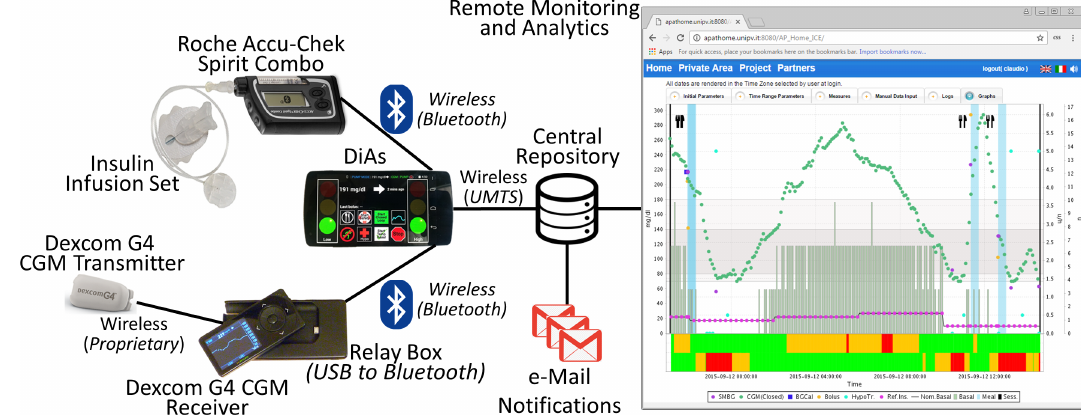
Figure 4. The architecture illustrating the components used in the final trial of AP@home , with the Diabetes Assistant acting both as a Body Gateway and as a Network Hub